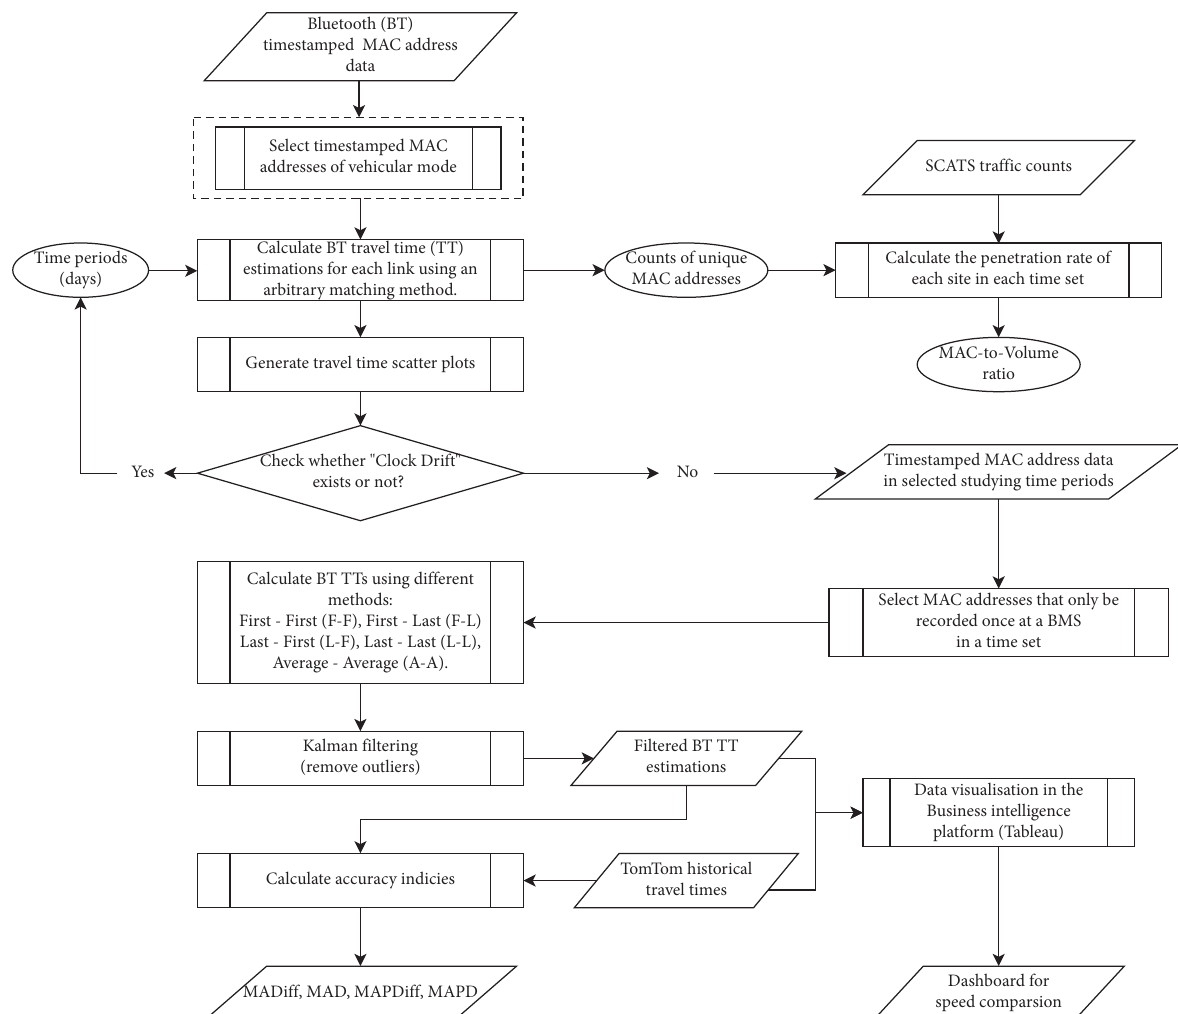
Figure 3: Offline framework of evaluating BT TT accuracy (the step in dash line box was skipped in this